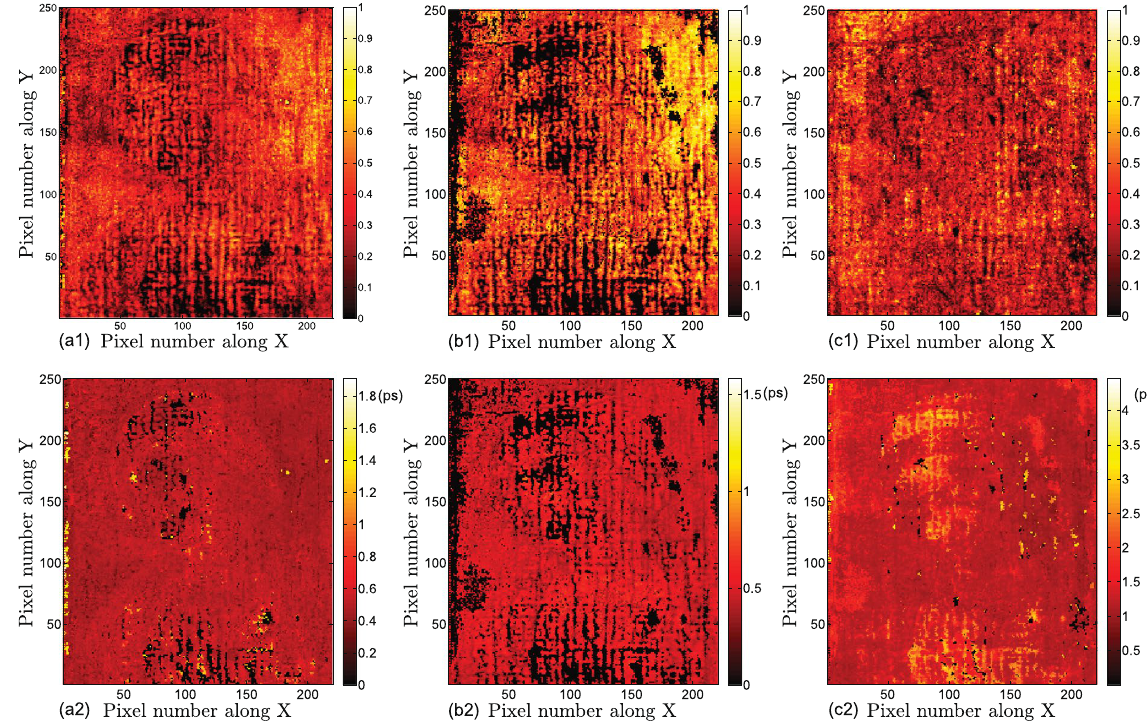
Figure 8. Features of the underpainting, imprimatura, and ground layers revealed by THz C-scans based on sparsity-based deconvolved signals. THz C-scans based on the amplitude of ( a1 ) the fourth, ( b1 ) fifth, and ( c1 ) sixth peak. Contrast is normalized to one. THz C-scans based on the optical delay between ( a2 ) the third and fourth peaks, ( b2 ) fourth and fifth peaks, and ( c2 ) fifth and sixth